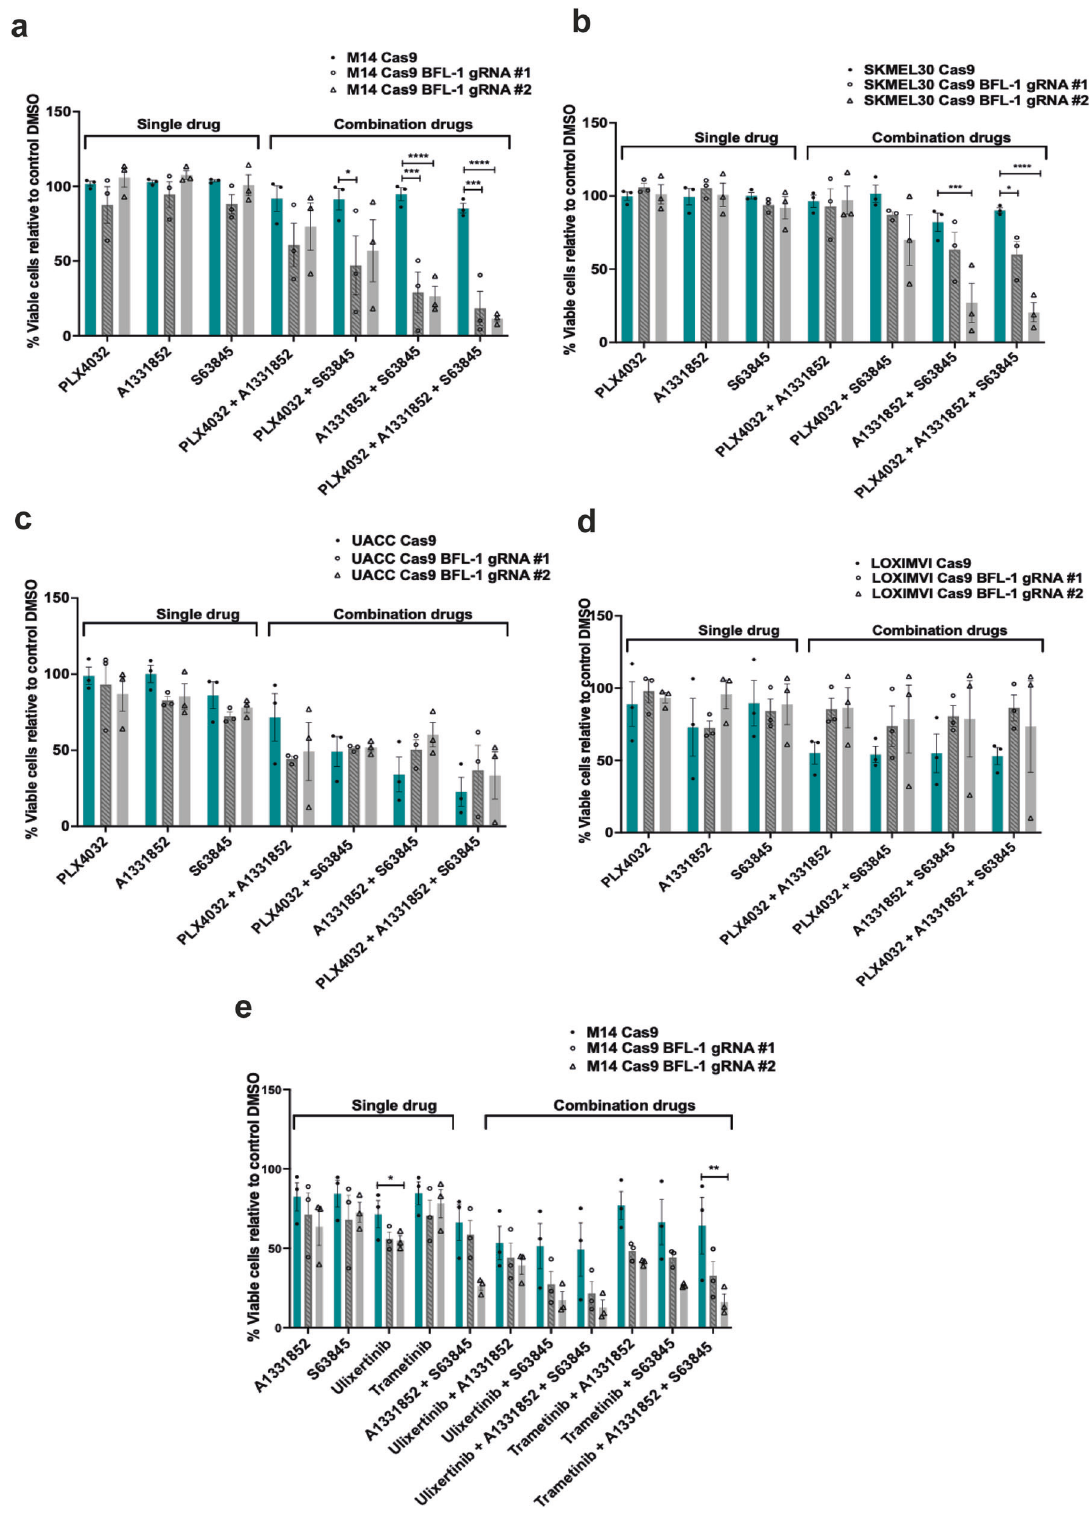
Fig. 1 Testing the responses of diverse parental and BFL-1 knockout human melanoma cell lines to different drug regimens. The survival of parental and BFL-1 knockout melanoma cells was determined by FACS analysis after staining with Annexin V-AF647 and DAPI after 72 h of treatment with the indicated drugs at the indicated concentrations. a – d 1 μ M MCL-1 inhibitor S63845, 1 μ M BCL-XL inhibitor A1331852 and 1 μ M BRAF inhibitor PLX4032 were used alone or in combination. e 1 μ M MCL-1 inhibitor S63845, 1 μ M BCL-XL inhibitor A1331852, 0.5 μ M ERK1/2 inhibitor Ulixertinib and 5 nM MEK1/2 inhibitor Trametinib were used alone or in combination. Data represent mean ± SEM of three independent experiments. P values were calculated by performing two-way ANOVA followed by multiple comparisons testing. * P < 0.05, ** P < 0.01, *** P < 0.001, *** P < 0.0001. DMSO was used as the vehicle control.